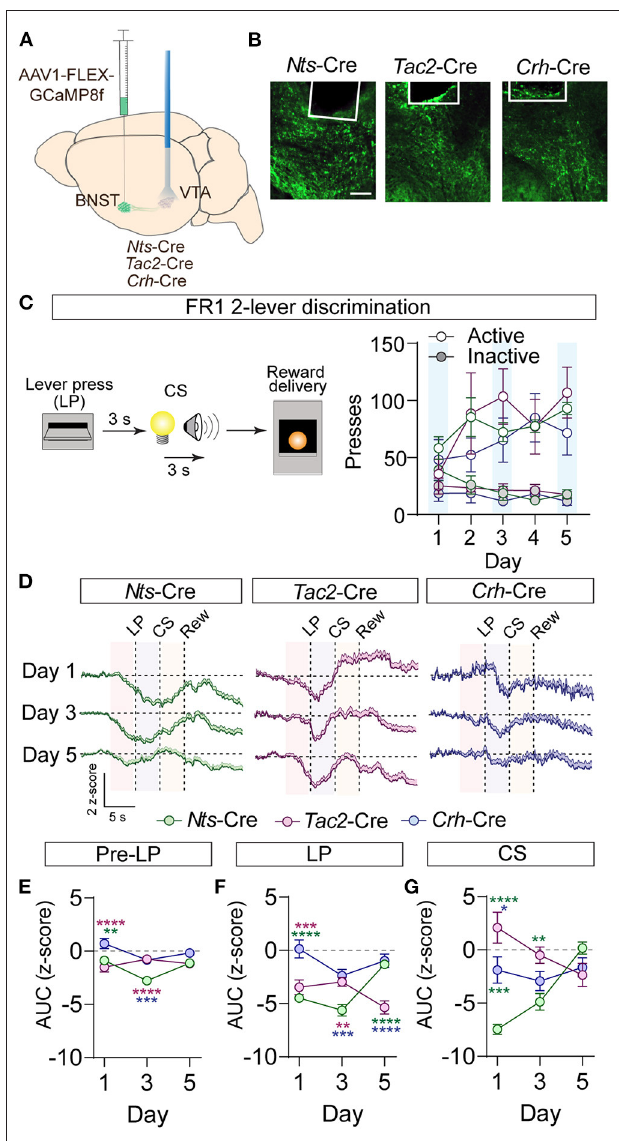
FIGURE 4 | GCaMP imaging of BNST → VTA axon terminals during operant conditioning in Nts-, Tac2-, and Crh -Cre mice. (A) Schematic of AAV1-FLEX-GCaMP8f injection in the BNST of peptide Cre lines and fiber optic implant for photometry in the VTA. (B) Example images of fiber placement and GCaMP terminal expression. Scale bar = 100 µ m. (C) Schematic of appetitive operant paradigm: a press on the active lever resulted in a 3s delay followed by a 3s cue delivery (tone plus light) that terminated with reward delivery. Right, number of presses on the active and inactive levers over 5 days of training ( n = 7 Nts -Cre, 5 Tac2 -Cre, and 4 Crh -Cre mice). (D) Average z-score ( + SEM) of the 1 F/F of the GCaMP signal aligned to active lever press for all trials from all mice for days 1, 3, and 5 of training. (E,F) Area under the curve of the z-score for the 3 second period prior to the lever